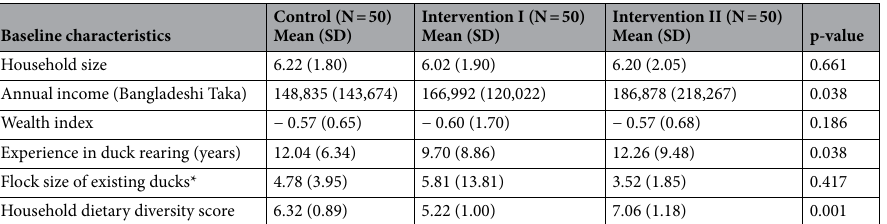
Table 1. Enrolment characteristics of duck raising households by treatment groups. *Number of households with existing ducks: control N = 18, intervention I N = 23, intervention II N = 16.